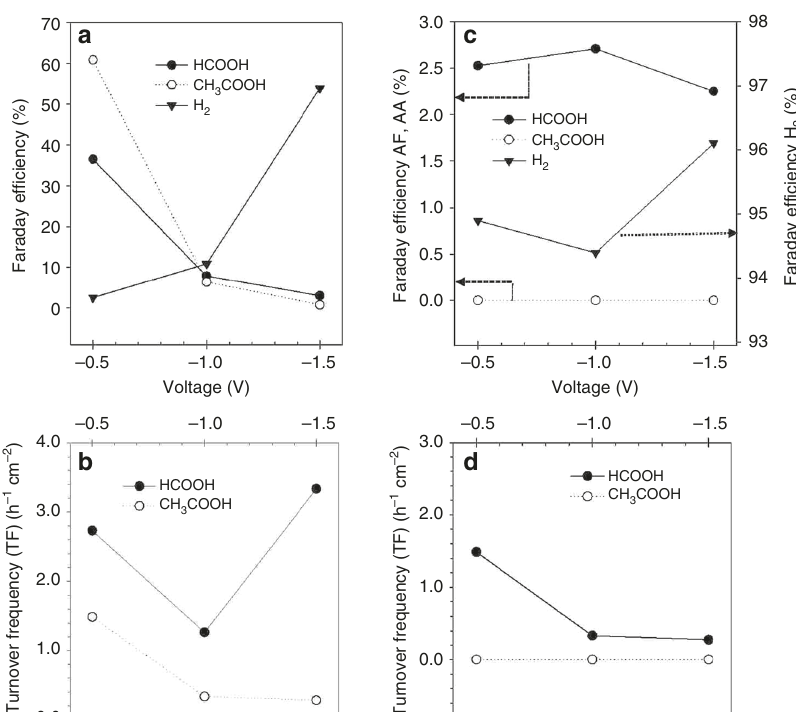
Fig. 6 CO 2 RR behavior of Fe/O-N sample and Fe/O-C samples. a Faraday ef fi ciency (%) to the products of CO 2 reduction under applied voltage of − 0.5, − 1, and − 1.5 V vs Ag/AgCl (3M KCl) for Fe/N-C sample and b corresponding turnover frequency (h − 1 cm − 2 ). c Faraday ef fi ciency (%) to the products of CO 2 reduction under applied voltage of − 0.5, − 1, and − 1.5 V vs Ag/AgCl (3M KCl) for Fe/O-C sample and d corresponding turnover frequency (h −